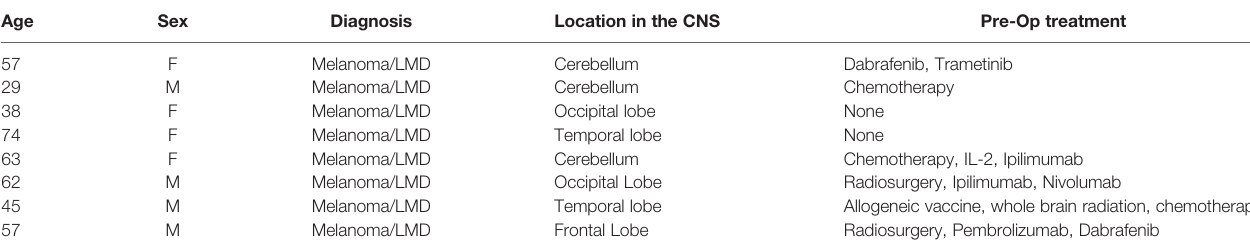
TABLE 1 | Demographics of melanoma patients with